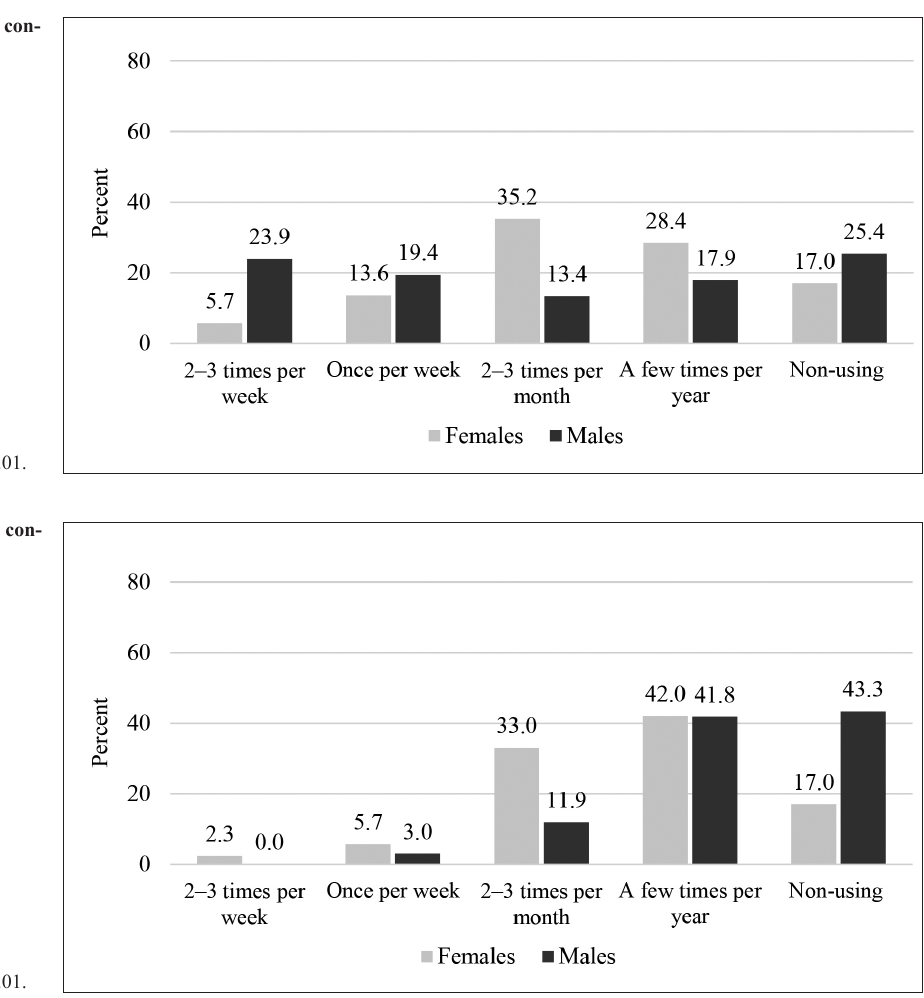
Figure 7. Frequency of beer con- sumption